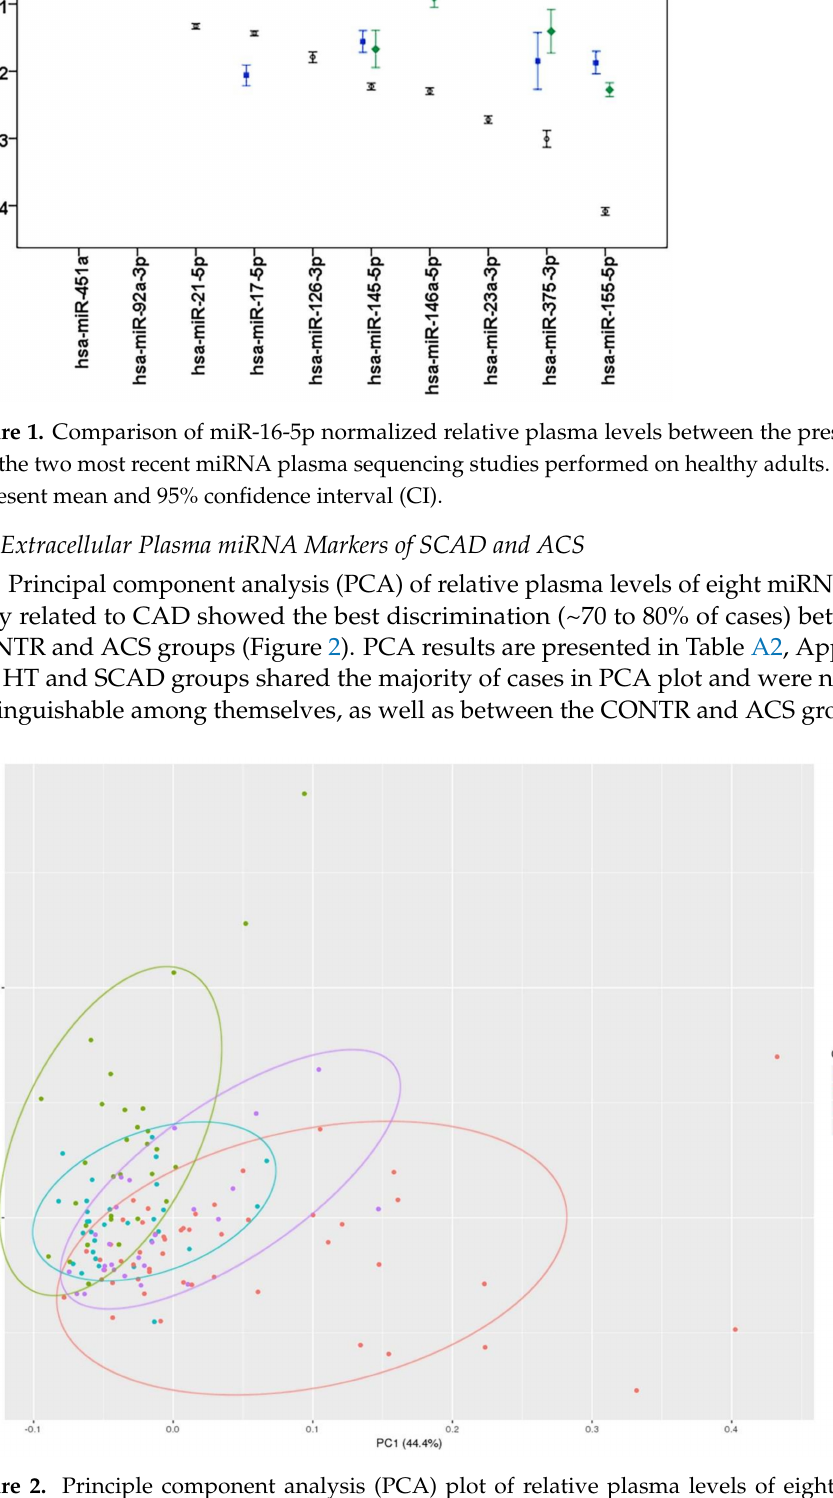
Figure 2. Principle component analysis (PCA) plot of relative plasma levels of eight analyzed miRNAs potentially associated with